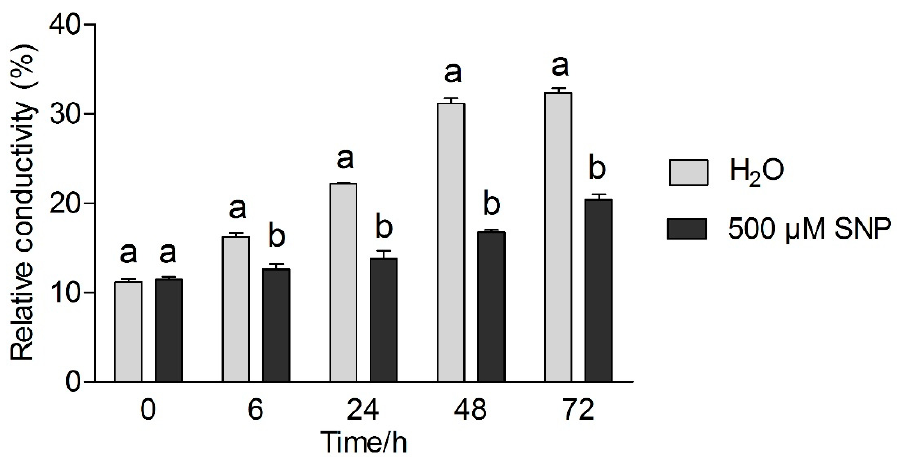
Figure 1. Effect of exogenous nitric oxide on electrolytic leakage in tea leaves under cold stress.